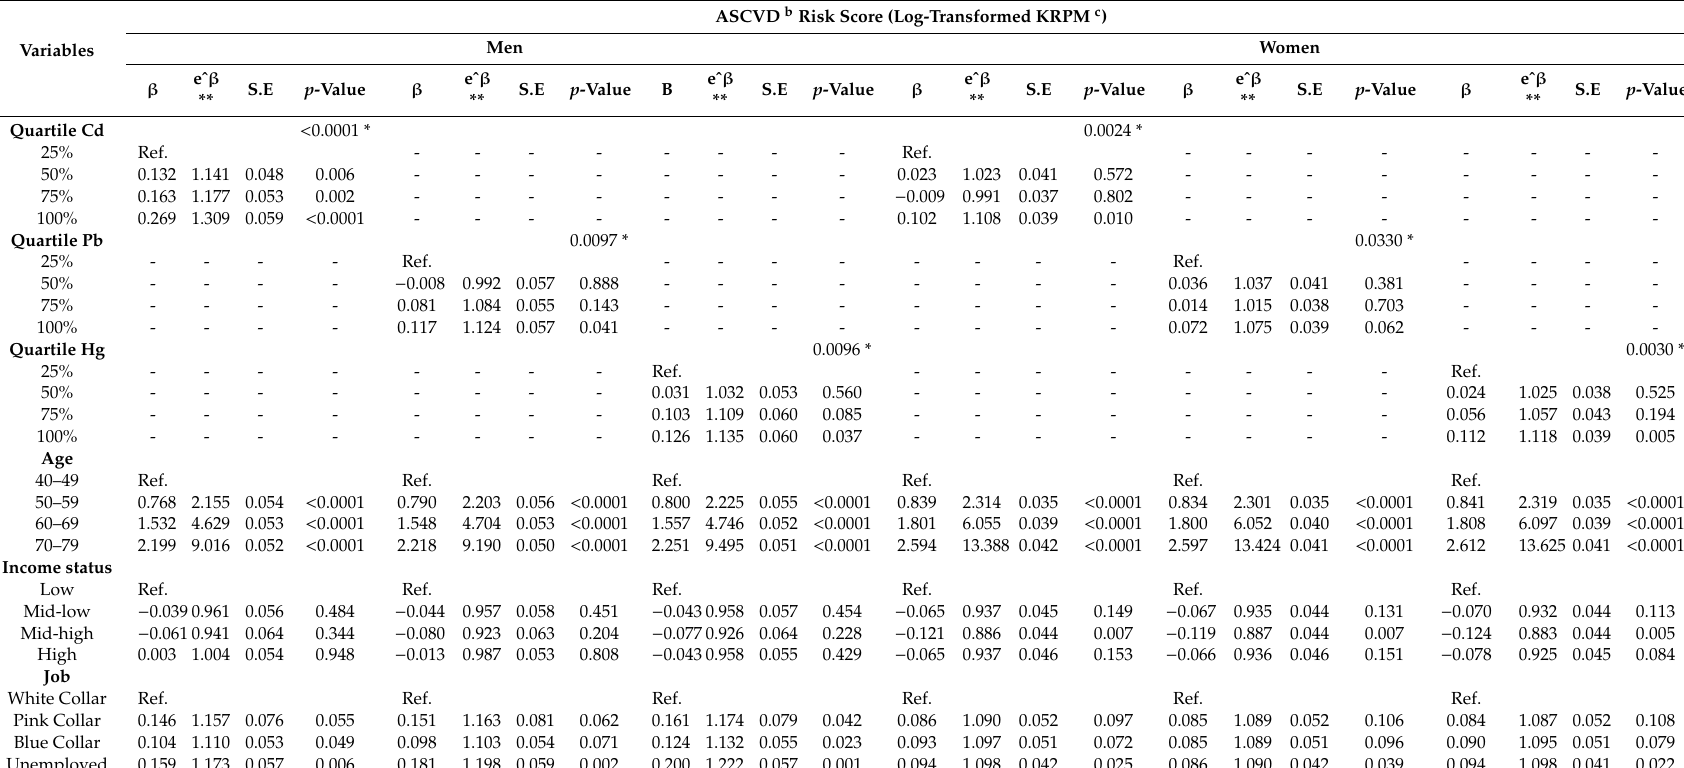
Table 2. Results of analyzing the e ff ect of the blood heavy metal